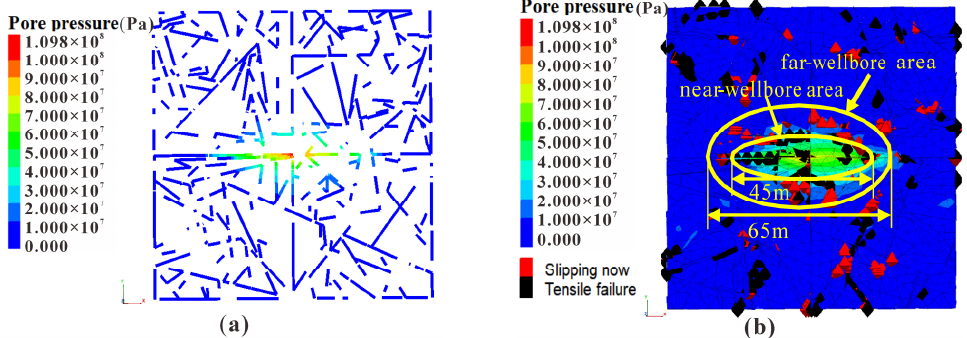
Figure 15. Fracture configuration after 1000 s of stimulation. ( a ) Profile of hydraulic fracture network. ( b ) Stress state at failure node. In ( a ) and ( b ), fractures are colored according to the pore pressure; tensile failure nodes are black, and shear failure nodes are red.